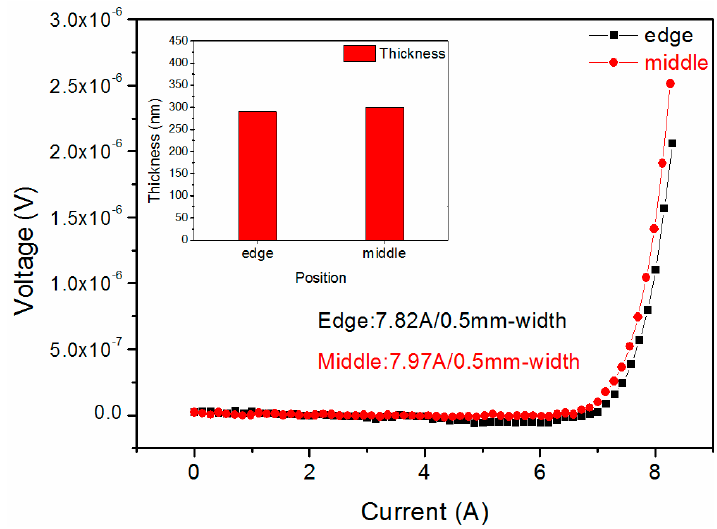
Figure 11. The thickness and I c histograms of GdYBCO films prepared based on the multi-aperture shower.